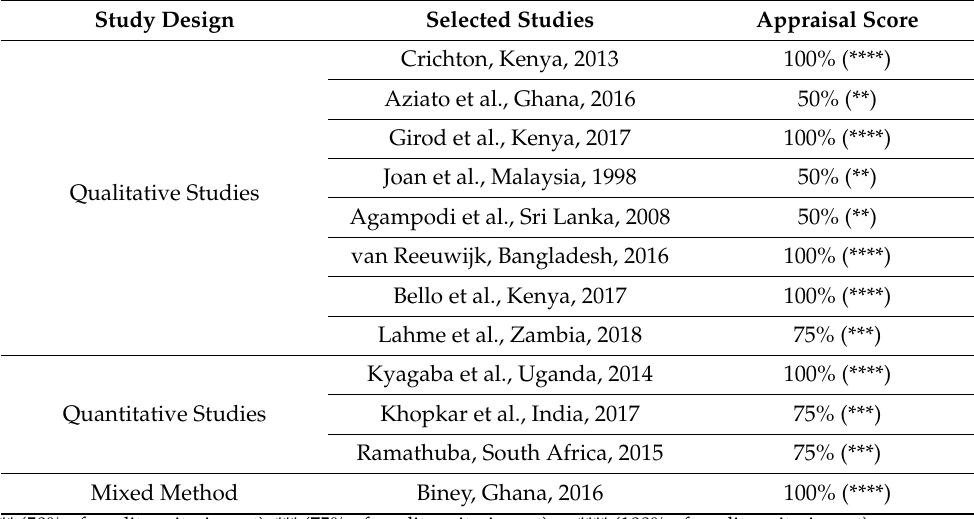
Table 3. Assessment of Methodological Quality According to the Mixed Methods Appraisal Tool (MMAT, Pluye et al.,